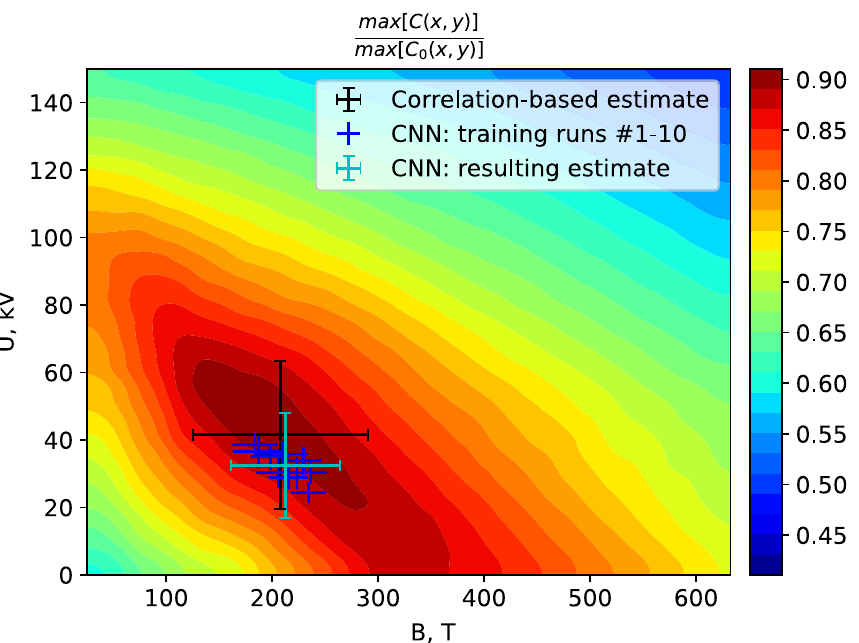
Figure 4. The peak value of cross-correlation between the normalised experimental and synthetic images as a function of the magnetic field in the target center and the electric potential of the target. The correlation peak f ( x , y ) f ( x + u , y + v ) . values are normalized per maximum of the autocorrelation function C 0 ( x , y ) = (cid:31) u , v Black cross with error bars shows the best-fit for the region of the maximum cross-correlation peak value. Positions of the blue crosses show the ANN-retrieved results obtained by each of the 10 models that were fit and validated on different subsets of the data, while their size indicates retrieval errors estimated by testing the model on the validation subsets created from the artificially created data. Cyan cross shows the resulting CNN- based estimate obtained by taking the mean of 10 predictions made by the models trained on different training runs, see Table 1; its error bars correspond to the uncertainty which results from the spread of the predicted values and the contour retrieval error, with the size of the interval corresponding to the 95% confidence